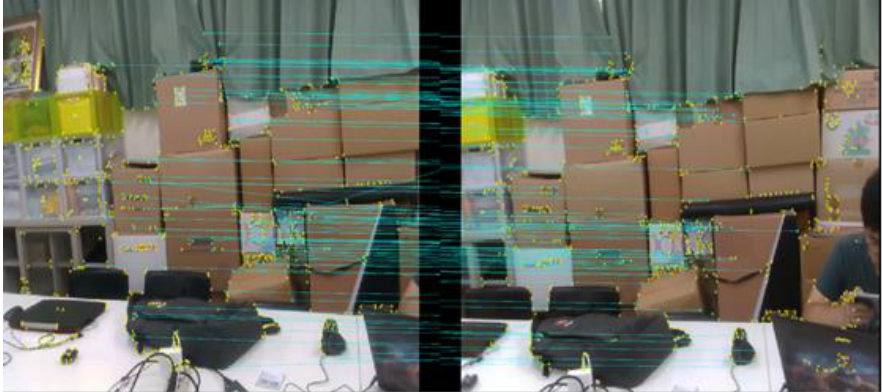
Figure 17. Simulation for feature-matching result.